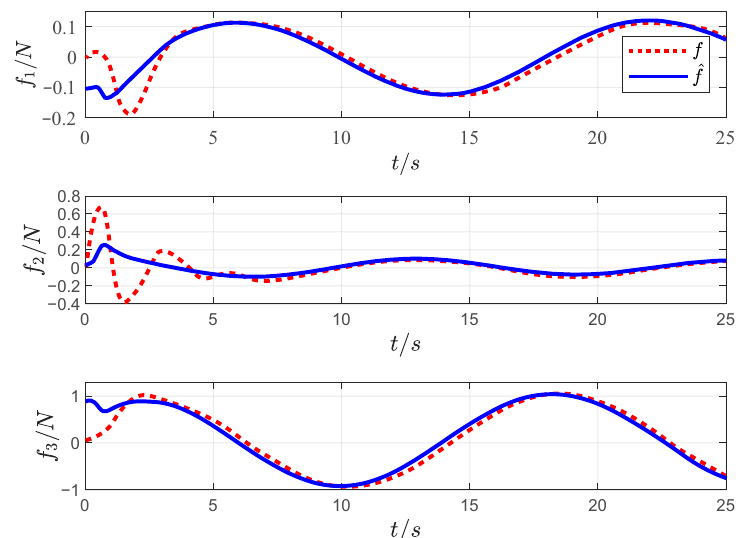
Figure 7. Lumped uncertainties estimation